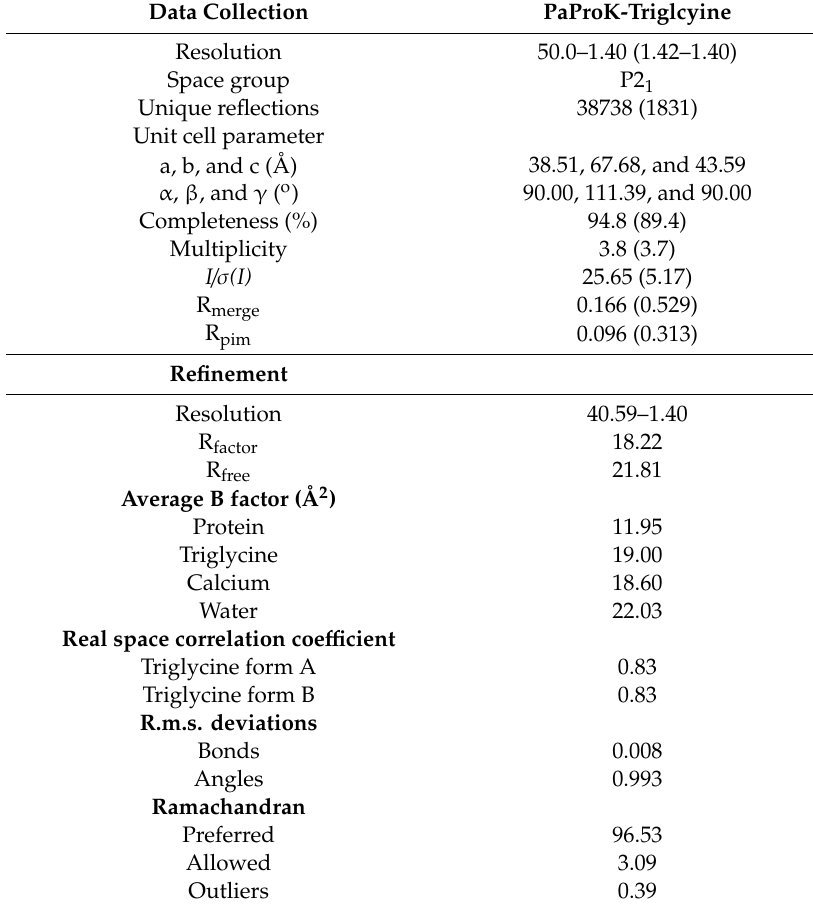
Table 1. Data collection and refinement